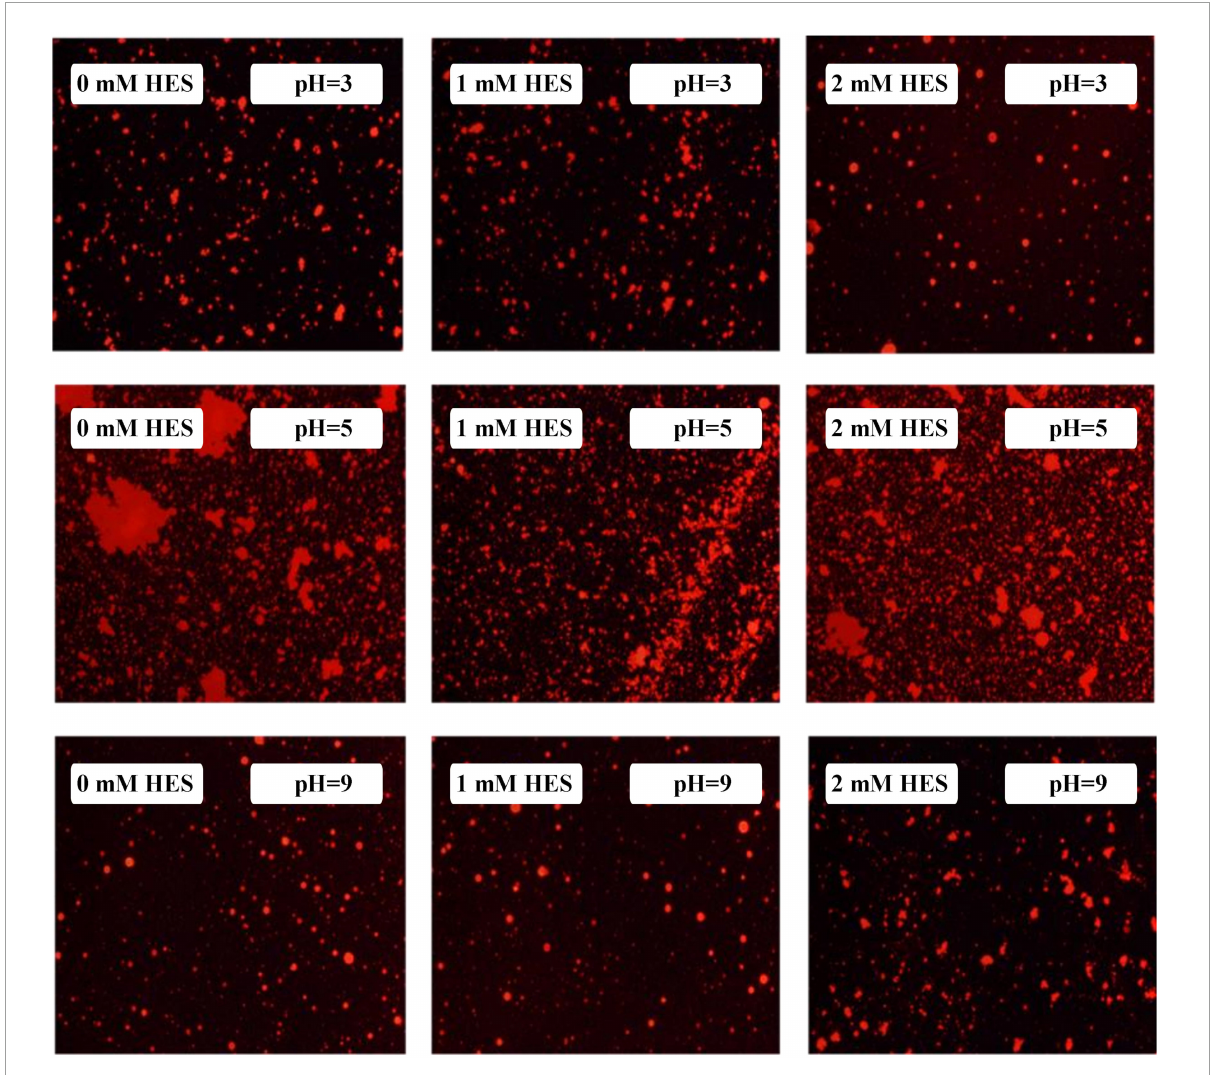
FIGURE8 The microstructure of WP based emulsion or WP-HES based emulsions at different pH